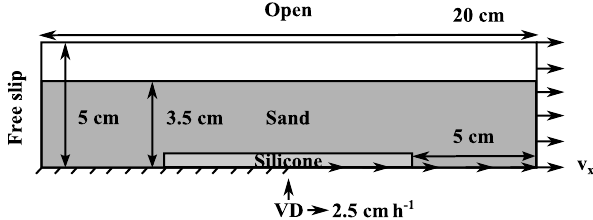
Figure 8. The sandbox experiment setup after Buiter et al. (2006). VD represents the velocity discontinuity moving at the same speed as is prescribed on the right and bottom boundary. Left of the VD, the bottom boundary is no slip. The left vertical boundary is set to free slip, while the top is open. The silicone layer measures 10 × 0 . 5cm.